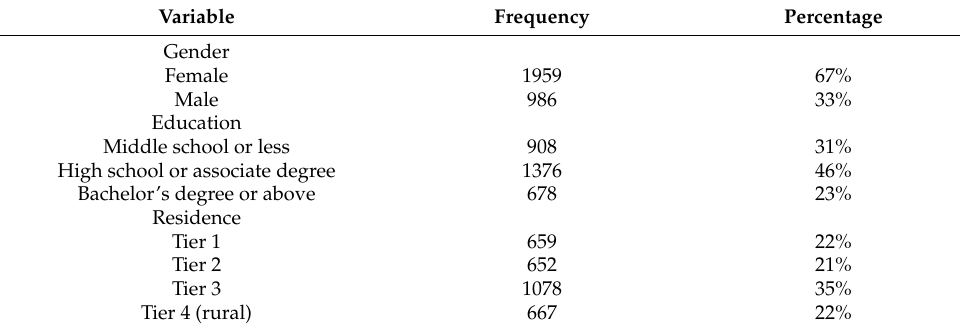
Table 2. Sociodemographic characteristics of